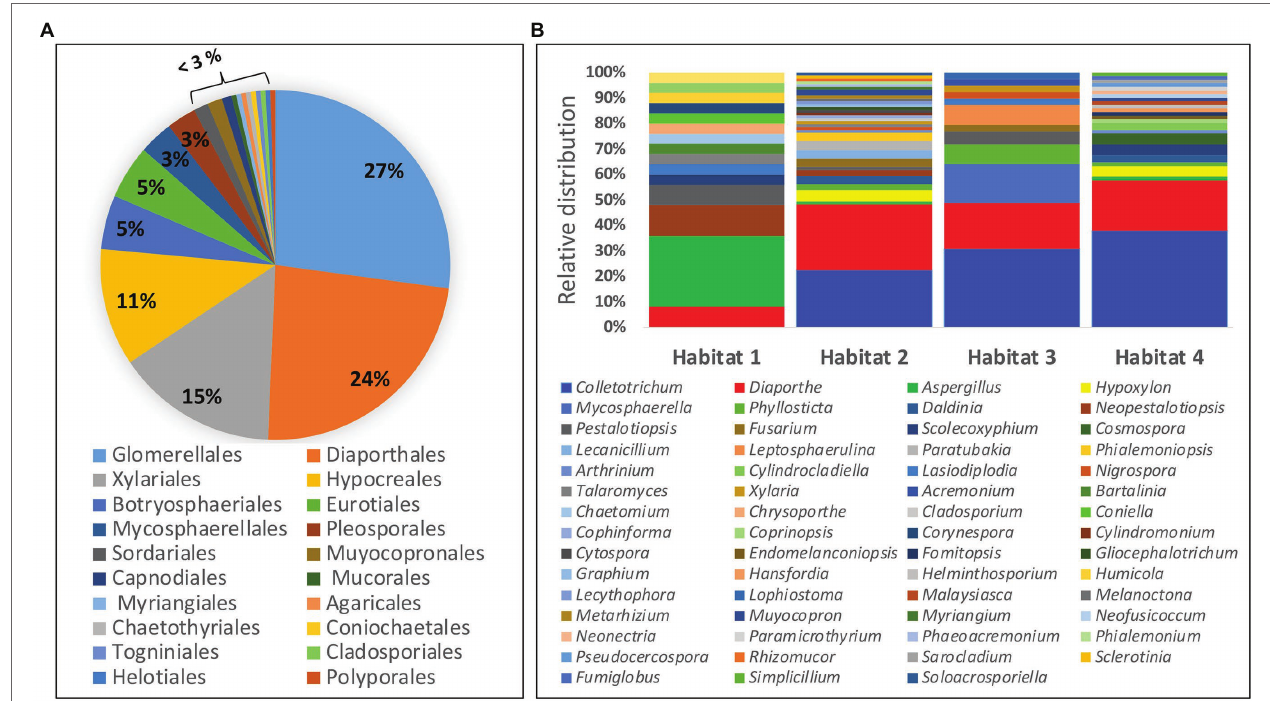
FIGURE 2 | Diversity and distribution of identified endophytic fungi: (A) Percentage of fungal strains belonging to each of the 20 identified orders. (B) Relative distribution of fungal endophytes from different genera within the four study